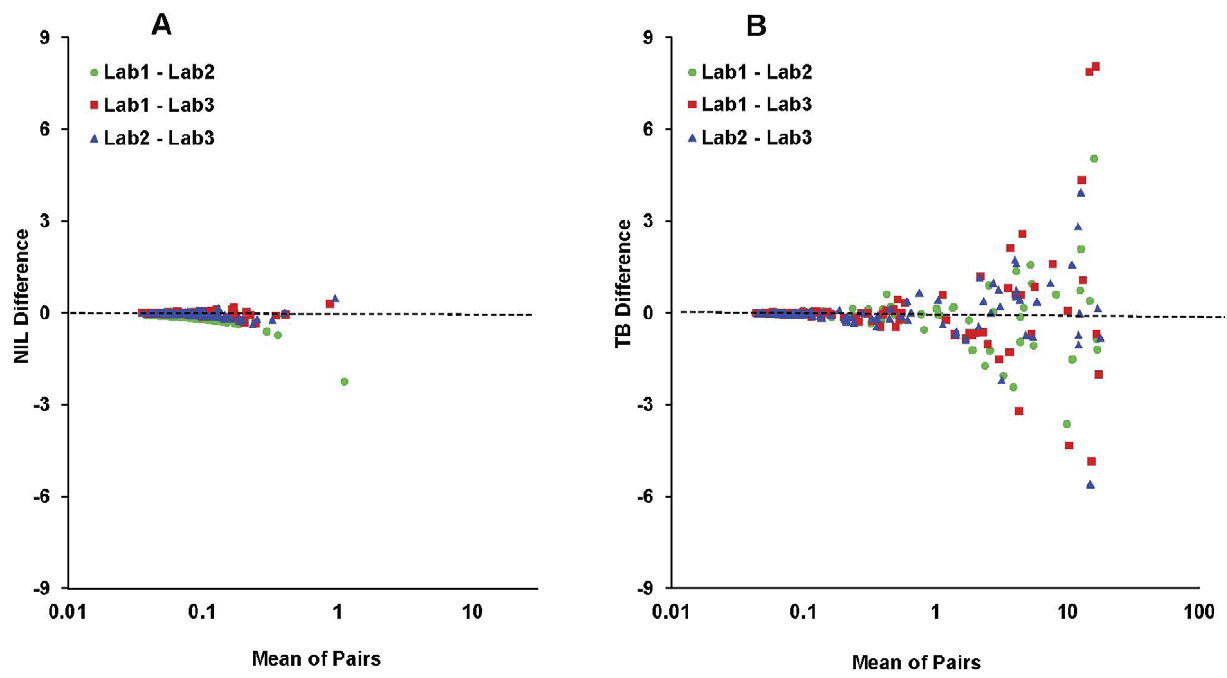
Figure 2. Difference (Bland-Altman) plots. Difference (Bland-Altman) plots for Nil (panel A) and TB (panel B). Differences (y-axis) and means of pairs (x-axis) are in IU/mL IFN- c .